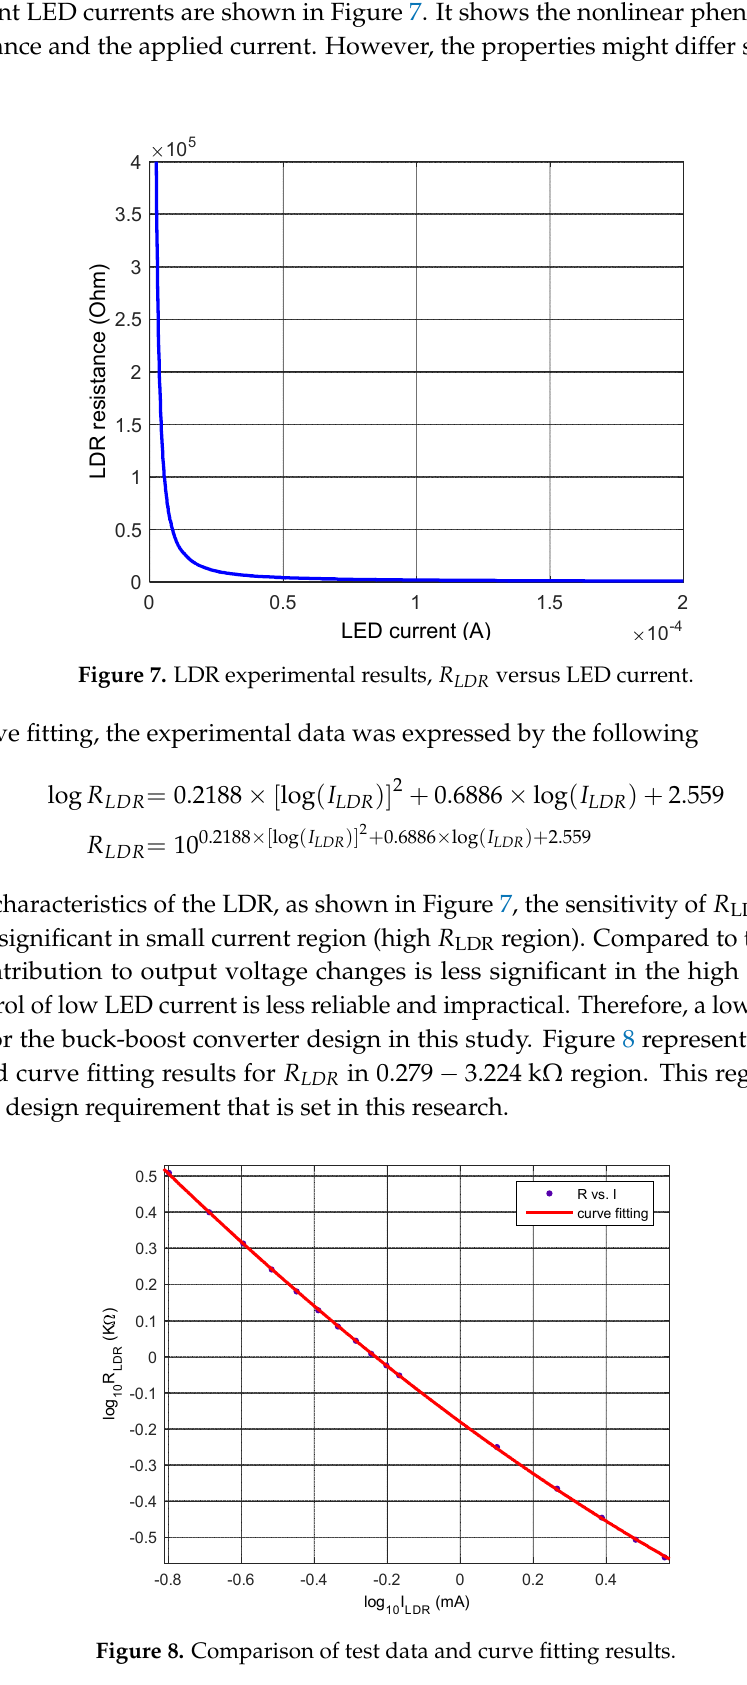
Figure 8. Comparison of test data and curve fitting results.